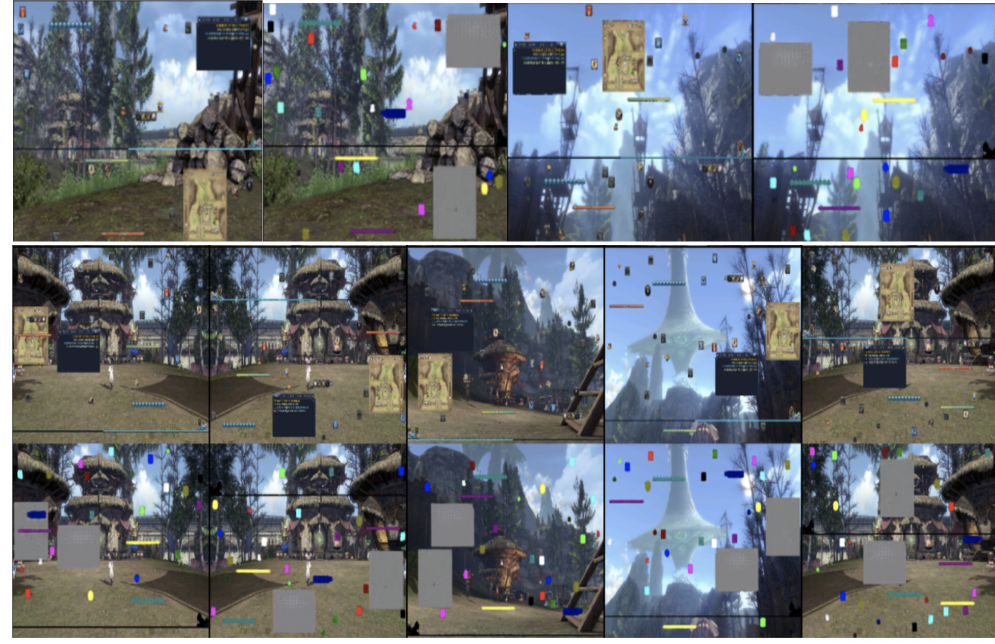
Figure 10. Result of Blade and Soul UI